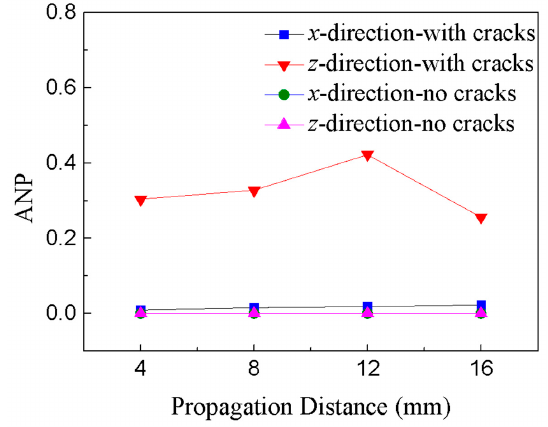
Figure 10. ANP (collected at position 1) versus the propagation distance.